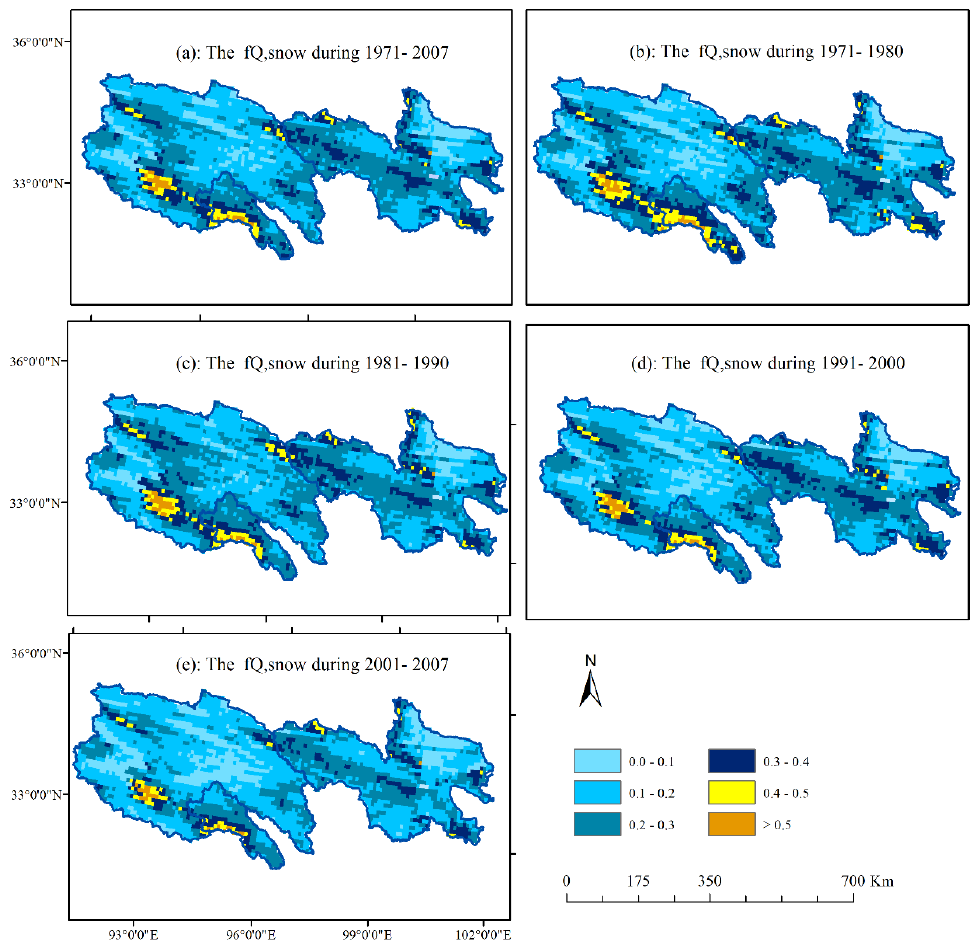
Figure 7. Spatial variation of the f Q,snow : ( a ) from 1971 to 2007; ( b ) 1970s; ( c ) 1980s; ( d )1990s; and ( e ) 2001 to 2007 over TRHR.